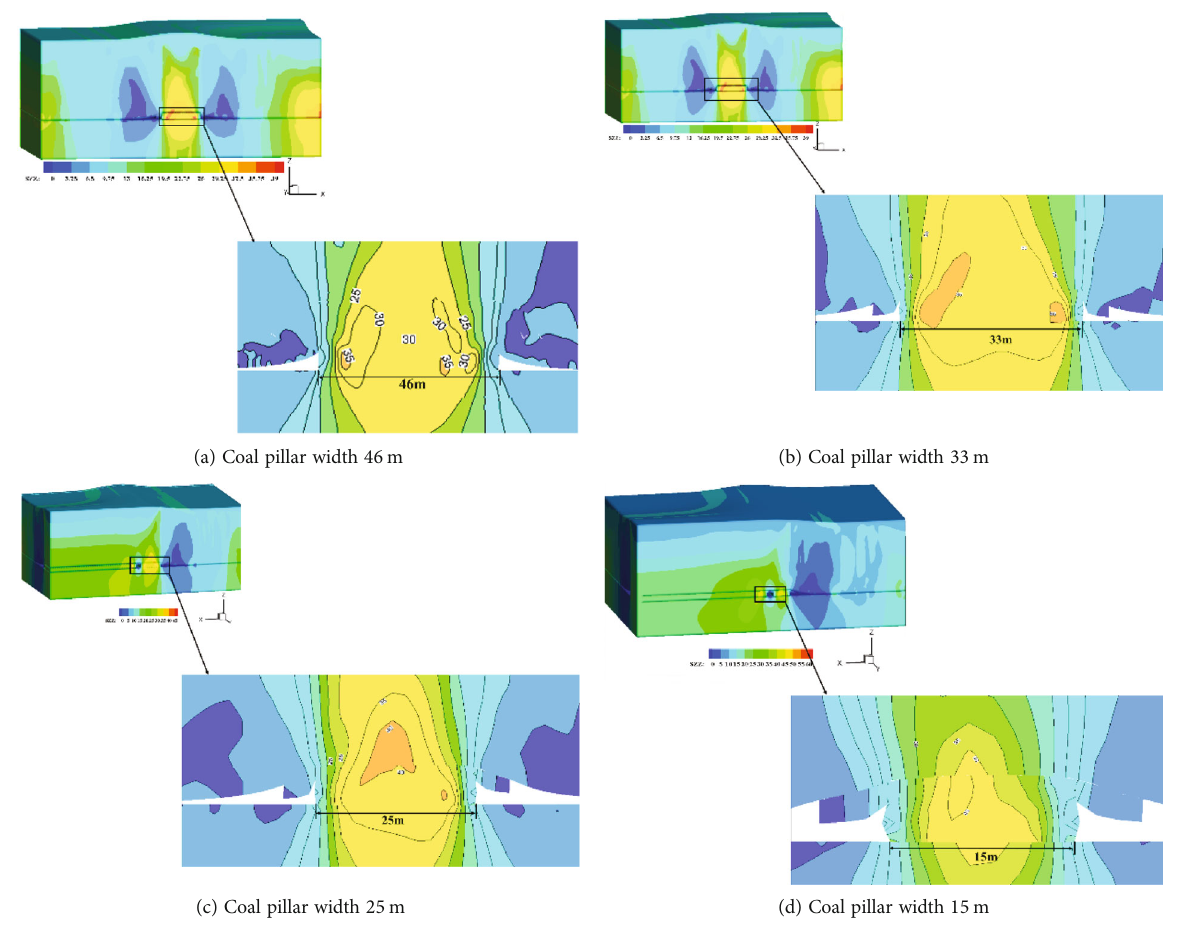
Figure 12: Vertical stress in the di ff erent coal pillars width.